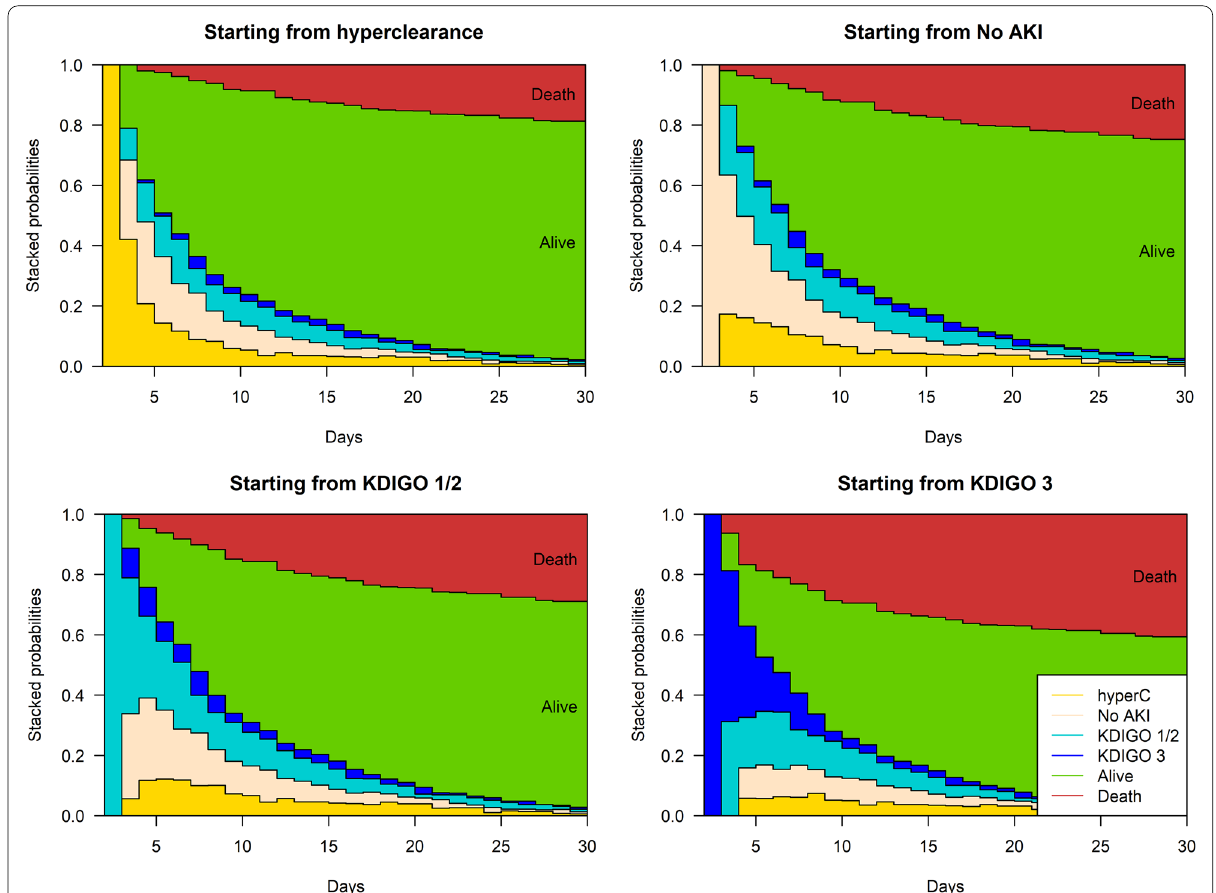
Fig. 4 Cumulative probability of being at a state at a given time after the ICU stay for patients with (from left to right) ARC at admission, without renal failure or ARC, with KDIGO (KDIGO (Kidney Disease: Improving Global Outcome score) 1 or 2 renal failure, and with KDIGO 3 renal failure at